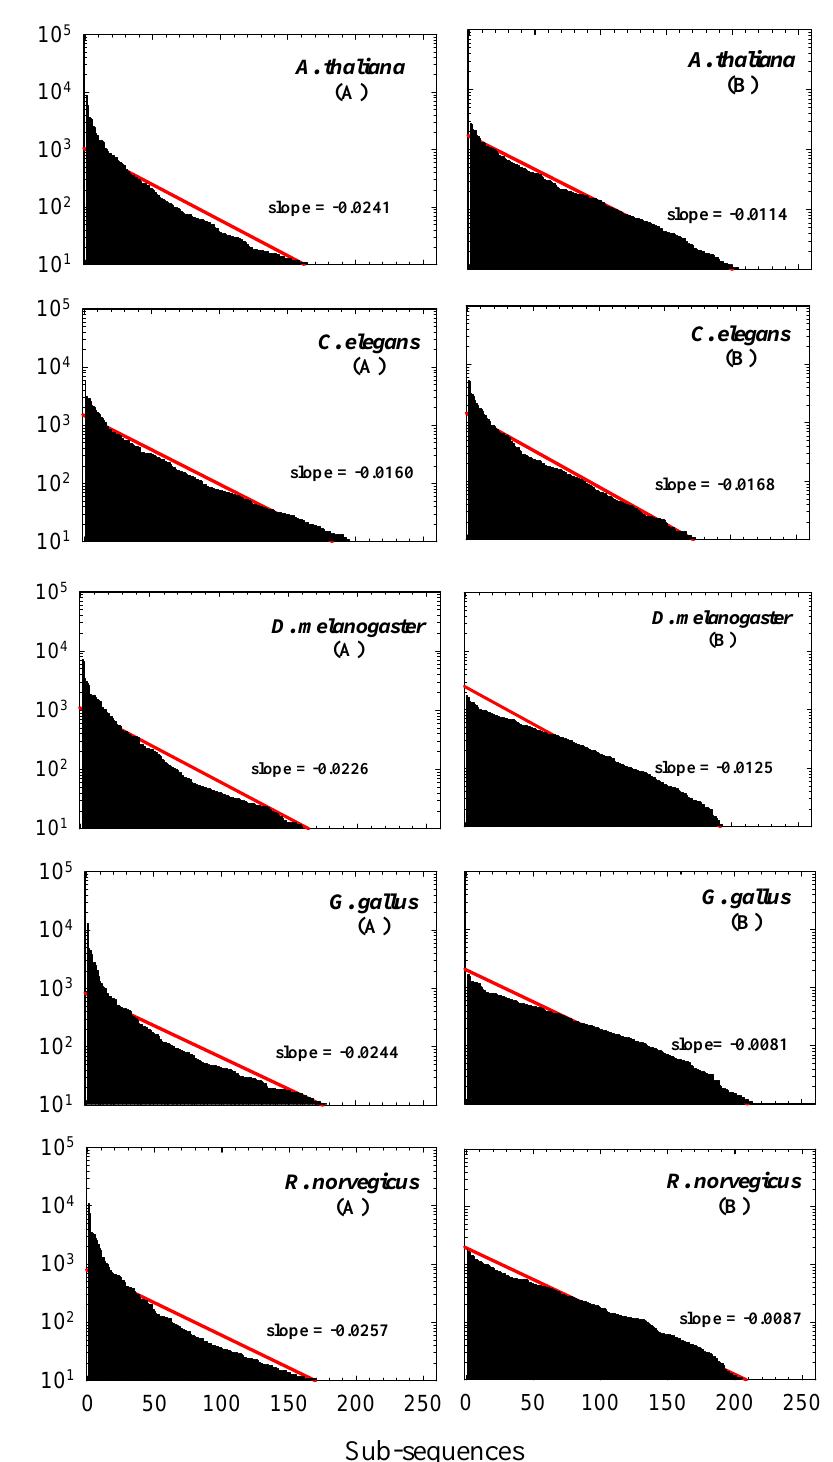
Fig 1. Vertical bar plots of the frequency of occurrence (log-scale) of the unique sub-sequences (arranged in descending order) in each set (first 65,535 sub-sequences considered) of size six of the respective organisms plotted against the corresponding sub-sequences (represented as numbers in linear scale) for the (A) donor and (B) acceptor splice site regions. Linear lines of regression are also shown (in red color) along with their respective slopes to indicate the trends of each plot. Scales of the axes are shown similar for all the organisms for the ease of comparison. The total area in each of the graphs is the